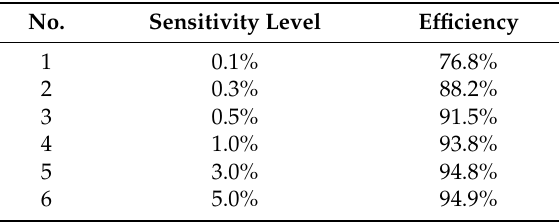
Table 7. Detection results of the different